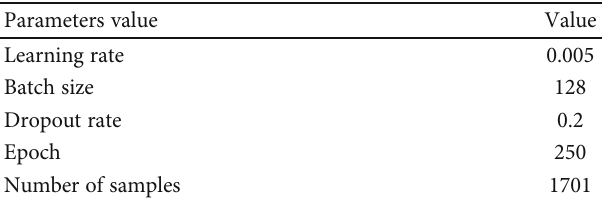
Figure 6: Diagram for the di ff erent activation functions and its characteristics (a – c). Table 2: Parameters for model training utilizing neural networks. Table 4: Dataset proportion neural